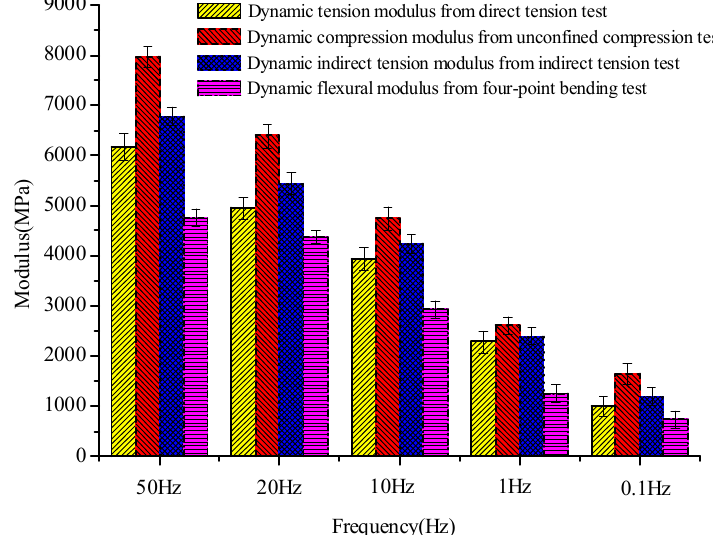
Figure 4. Dynamic moduli obtained by specified test methods.